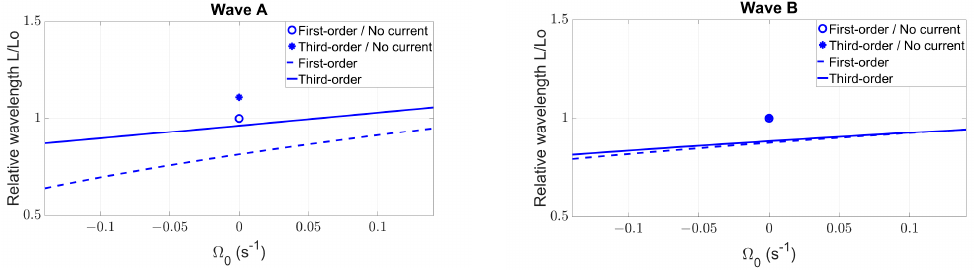
Figure 10. Relative wavelength as a function of vorticity. U m = − 0.35 m/s.